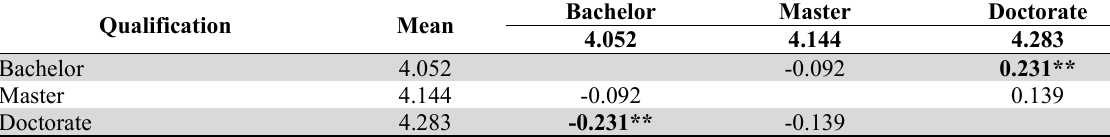
Scheffe test for information accuracy depending on qualification